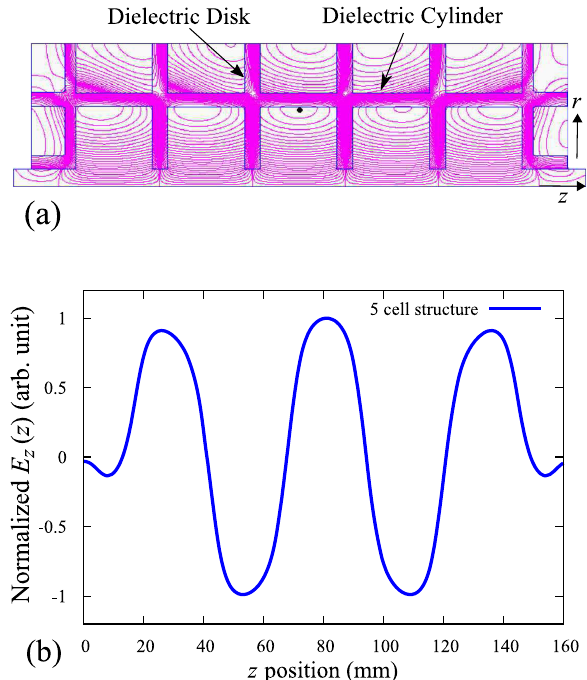
FIG. 9. (a) Electric field lines of the accelerating mode excited in the 5 cell DAA structure. (b) Normalized longitudinal electric field strength in the 5 cell DAA structure.